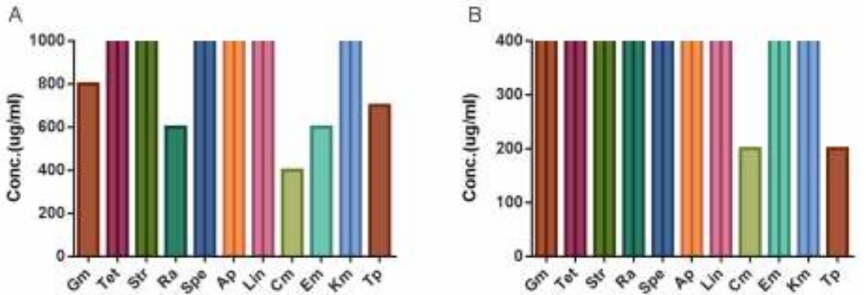
Figure 2. The minimum inhibitory concentration (MIC) test of Smal-007. ( A ) MIC of 11 antibiotics. ( B ) MIC of 11 antibiotics with the uncoupler CCCP. Smal-007, Stenotrophomonas maltophilia Smal-007. CCCP, carbonyl cyanide m-chlorophenyl hydrazine. 11 antibiotics, Gm: